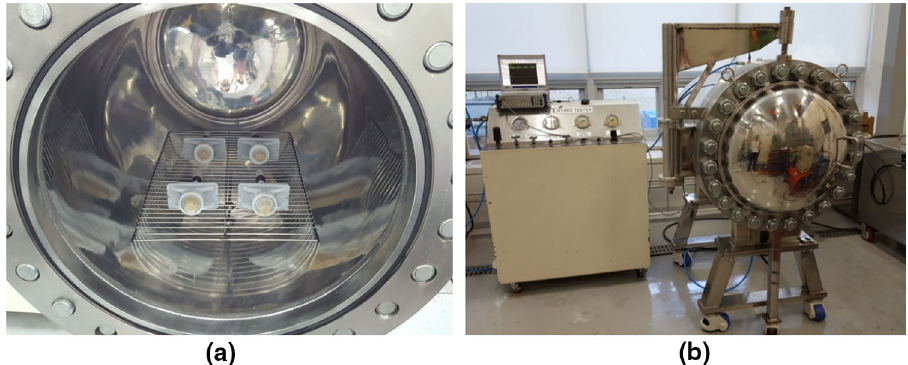
Fig. 4 a Four specimens inside hydrostatic test chamber and b overview of hydrostatic test chamber.